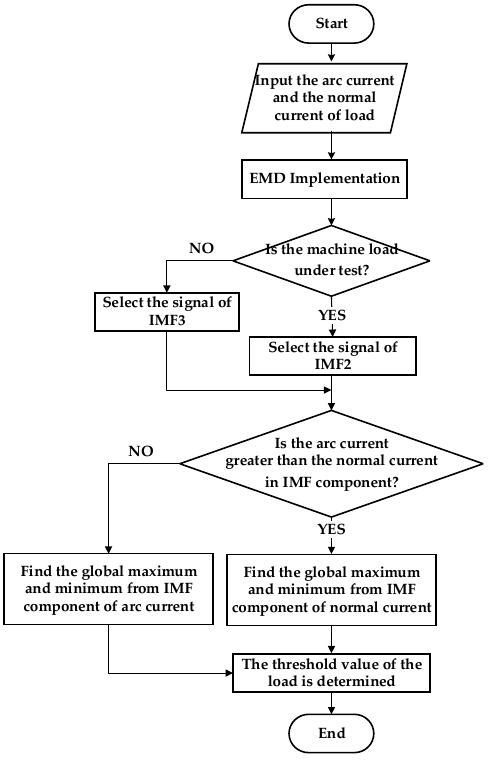
Figure 11. Setting of the threshold for the